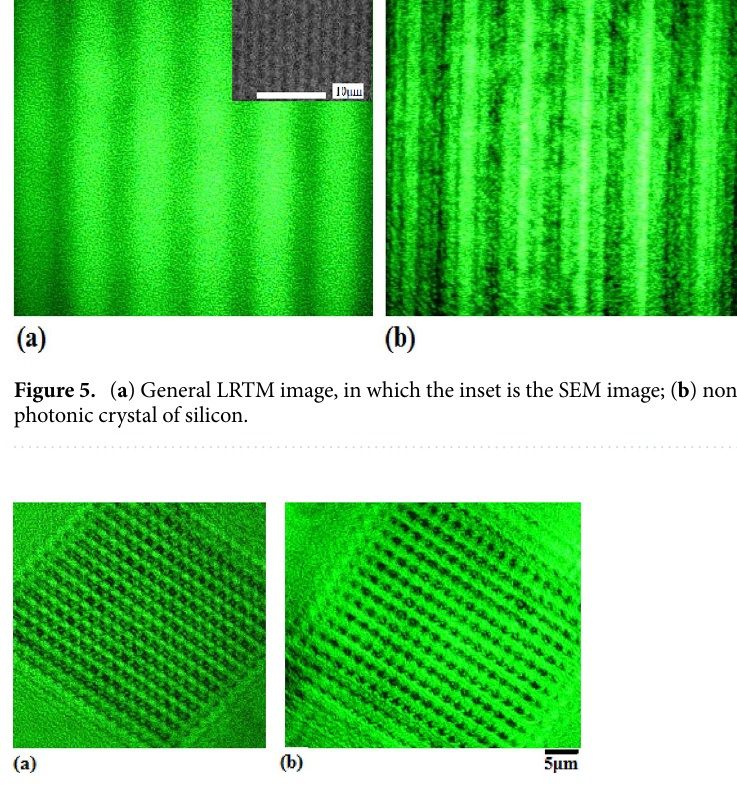
Figure 6. ( a ) General LRTM image and ( b ) nonlinear LRTM image on 2D photonic crystal of